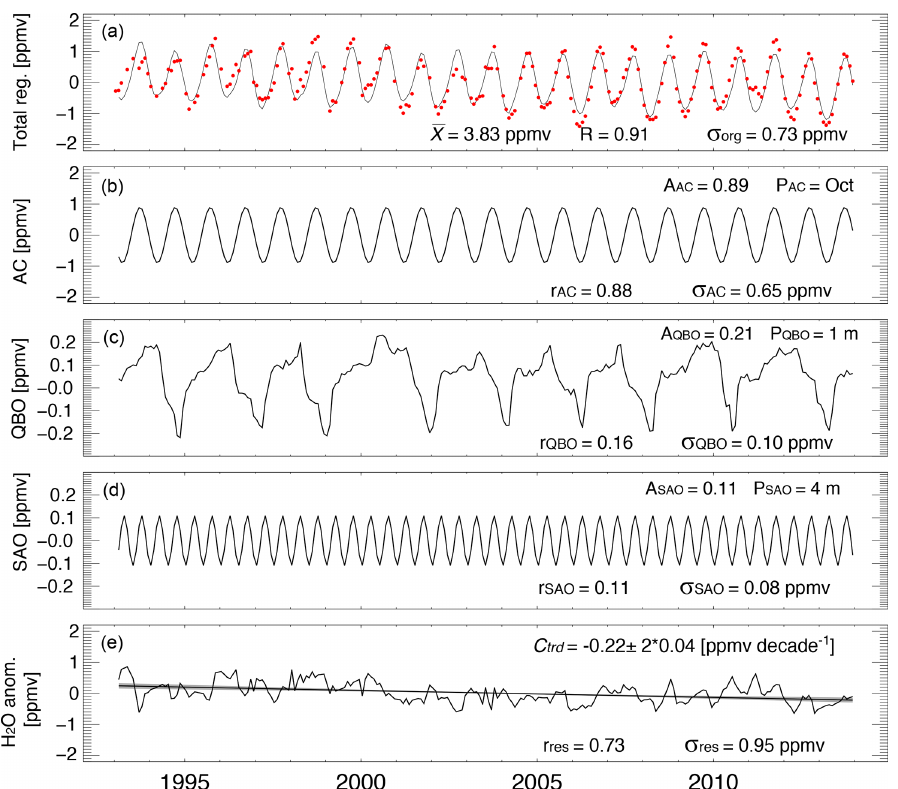
Figure 1. Multiple linear regression results for monthly-averaged tropical mean (20 ◦ S–20 ◦ N) water vapor on the θ = 400K isentropic surface from SWOOSH. The top panel (a) shows anomalies of SWOOSH data relative to the mean value over the 1993–2013 period (red dots) and the regression fit (black line) based on Eq. (5) (correlation coefficient r = 0 . 91). The AC, QBO and SAH components of the regression are shown in panels b, c and d , respectively. Additional variability beyond the three periodic and quasi-periodic components (residuum of the regression) is shown in the bottom panel (e) . The linear trend in this time series is also shown with ± 2 σ uncertainty shown as gray shading. Note the different y -axis ranges across the different panels. The amplitudes and phases of the AC, QBO and SAH signals are listed in the upper-right corners of the corresponding panels. The standard deviations corresponding to each contribution are listed near the bottom of each panel, together with correlation coefficients for each term against the original time series. The standard deviation of the original SWOOSH time series ( σ org ) is